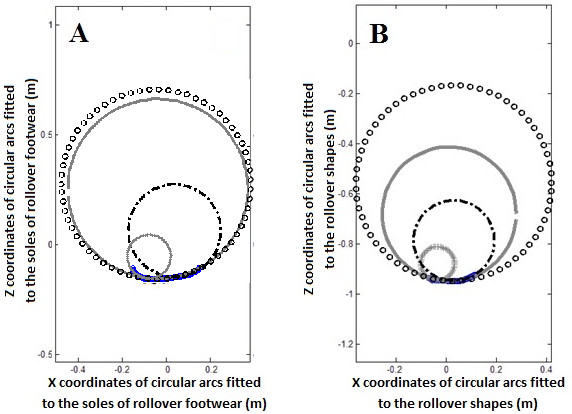
Average circular arcs of the shoe sole and rollover shapes. A: Average circular arcs of the whole shoe sole (Solid line) and the first (Plus sign), second (Circle) and final third (Dashed line) of shoe sole. B: Average circular arcs of the whole rollover shapes (Solid line) and the first (Plus sign), second (Circle) and final third (Dashed line) of rollover shapes.